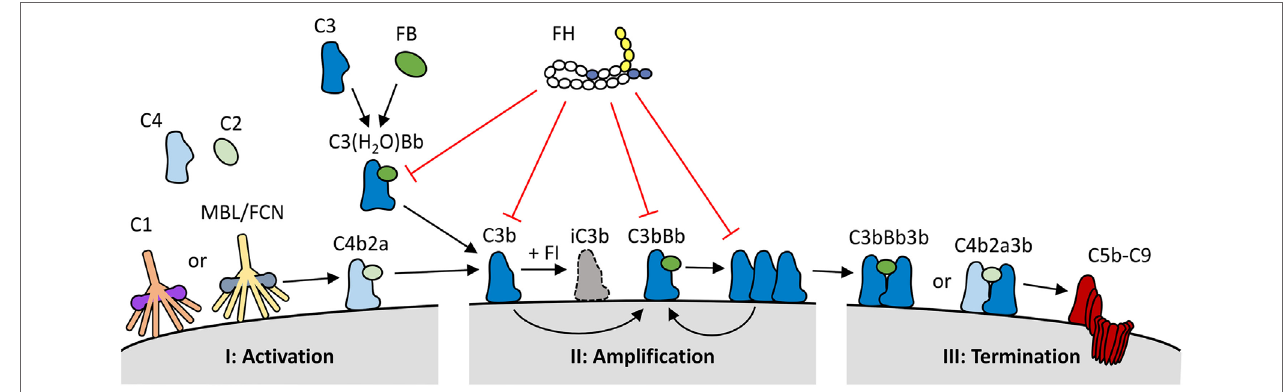
FigURe 1 | Overview of the role of factor H (FH) within the complement system. (I) The complement system is activated via binding of C1q (classical pathway), or mannan binding lectin/ficolins (MBL/FCN) (lectin pathway) in complex with serine proteases to specific molecules, or through the spontaneous activation of C3 into C3(H 2 O) (alternative pathway). Upon activation, the three pathways form C3 convertases (C4b2a or C3(H 2 O)Bb) resulting in the generation and deposition of C3b on the activating surface. (II) C3b forms new C3 convertase molecules (C3bBb) that enhance C3b deposition and amplify complement activation. (III) C3b can also bind to C3 convertases to generate C5 convertases (C4b2a3b or C3bBb3b); this process initiates the terminal pathway of complement activation, and the formation of the lytic C5b–C9 complex. FH keeps the spontaneous activation of C3 under control, and it also inhibits the complement system at both the activation and amplification stages. FH binds to deposited C3b and C3bBb complexes on human cell surfaces and inhibits further activation by three mechanisms: it competes with factor B (FB) for C3b binding and C3bBb generation; it increases the decay of C3bBb complexes, and it acts as a cofactor for factor I (FI), which in turn cleaves C3b into inactive C3b